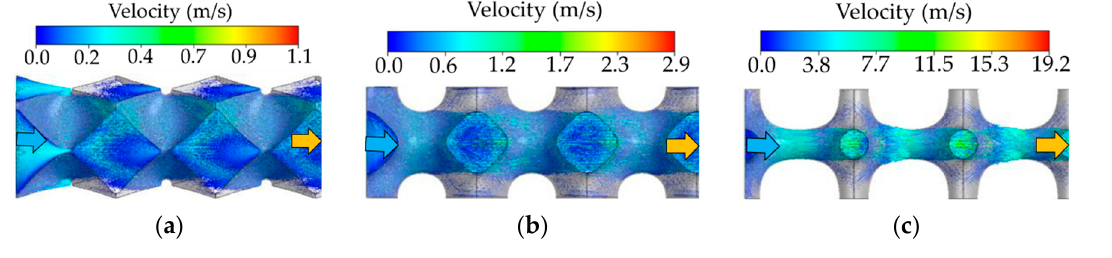
Figure 11. Velocity vector in the sheet-Primitive structure for different porosity values: ( a ) ε = 70%; ( b ) ε = 50%; ( c ) ε = 20%. (More flow details are shown in Ref. [58]).